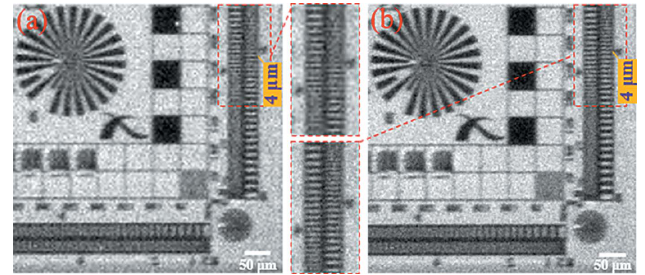
Figure 12 Experimental results verifying the effect of the source PSF in the horizontal on the micro-scanning method. ( a ) The projection (pixel size: 3.57 m m (cid:2) 3.57 m m; pixel number: 134 (cid:2) 134). ( b ) The oversampled image with deconvolution (pixel size: 1.785 m m (cid:2) 1.785 m m; pixel number: 268 (cid:2) 268). Panels ( a ) and ( b ) are only part of the image to show the details more clearly.